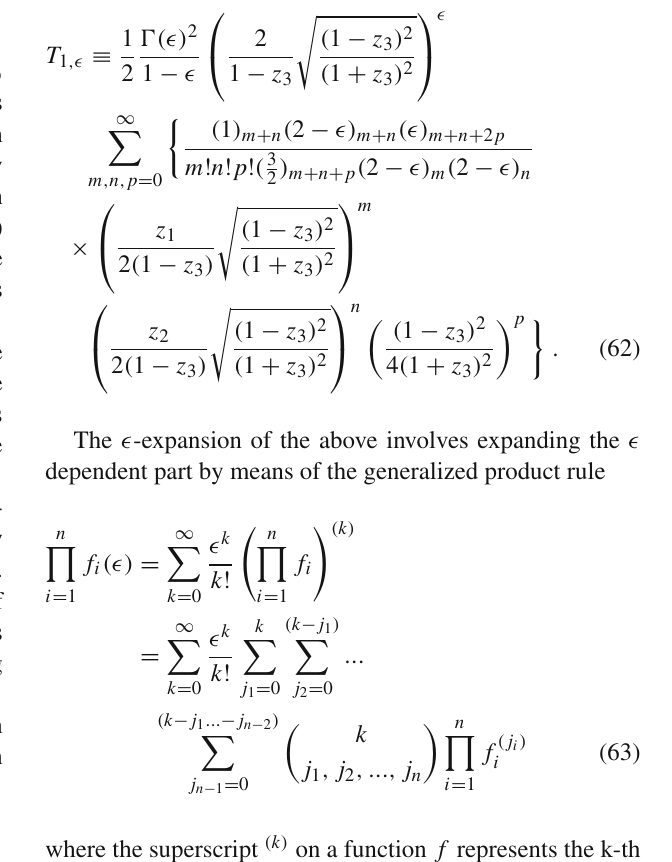
Fig. 11 New area of the real ( z 1 , z 2 , z 3 ) -space that can be reached by adding the regions of validity of the new series representations S i ( i = 5 ,..., 10) and of the series deduced from them by permutations of the